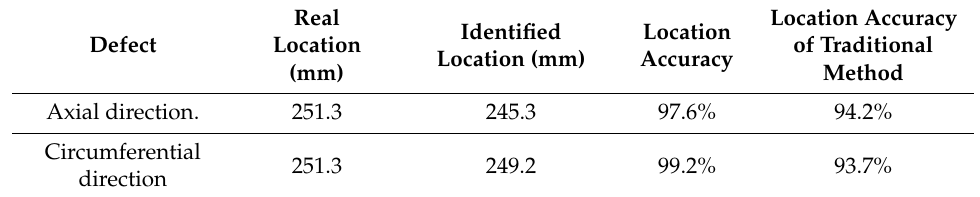
Table 3. Quantitative identification results of the defect.